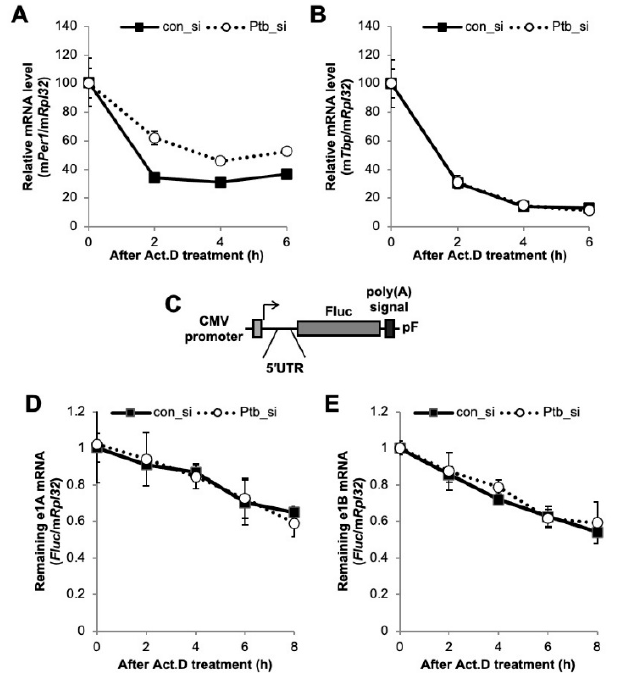
Figure 4. The function of polypyrimidine tract-binding protein 1 (PTBP1) on the Per1 mRNA. (A and B) Con_si or Ptb_si transfected NIH 3T3 cells were treated with actinomycin D (Act. D) and harvested at the indicated time points. Relative endogenous mRNA levels of ( A ) Per1 and ( B ) Tbp were determined by real-time PCR and normalized to the Rpl32 mRNA levels at the indicated time points. ( C ) Schematic diagram of the Per1 5 (cid:48) -UTR reporter system. ( D , E ) The Per1 5 (cid:48) -UTR reporters were transfected into NIH 3T3 cells with con_si or Ptb_si. After 24 h of incubation, the cells were treated with Act. D and harvested at the indicated time points. Relative Fluc mRNA levels were determined with respect to the endogenous Rpl32 . The initial relative mRNA levels of con_si were set to 100. n = 4; the values are means ± standard error of mean